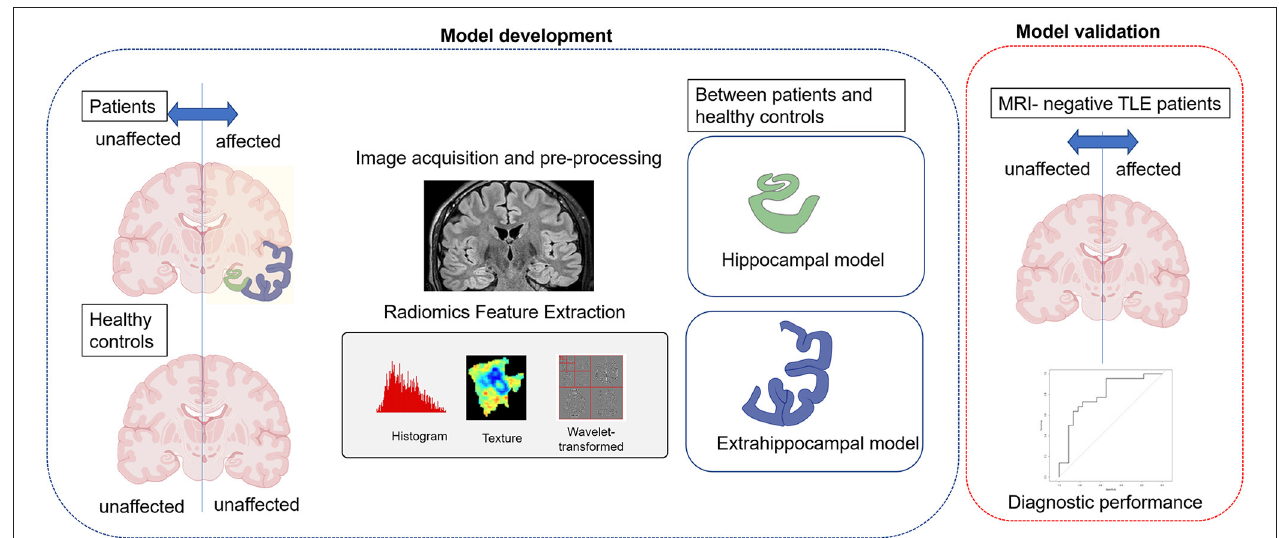
FIGURE 2 | A schematic diagram of the study. First, hippocampal and extrahippocampal radiomic models were constructed using the training set and features showing significant differences between the affected and unaffected side. Second, independent validation was performed in patients with magnetic resonance imaging (MRI)-negative temporal lobe epilepsy (TLE) to evaluate the models’ ability to diagnose laterality (the affected side).